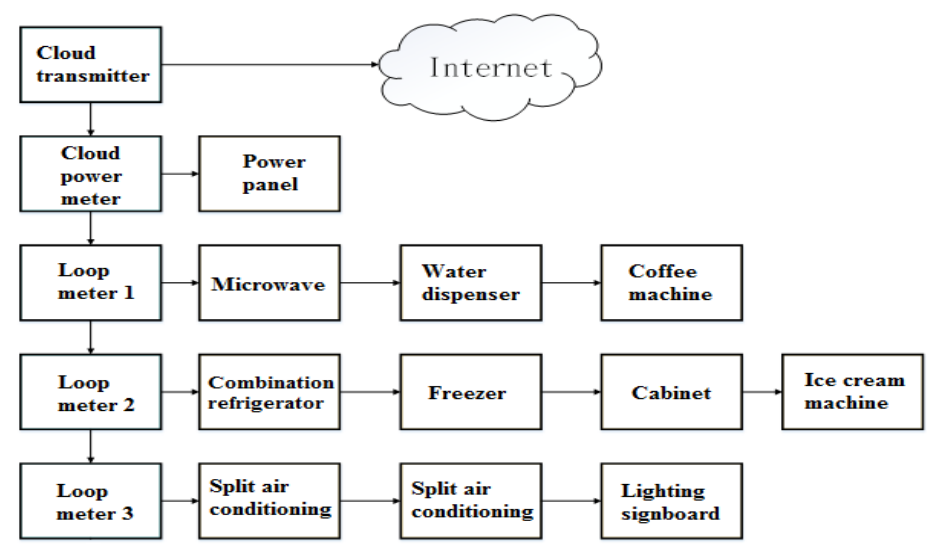
Figure 2. Power data acquisition system (PDAS).